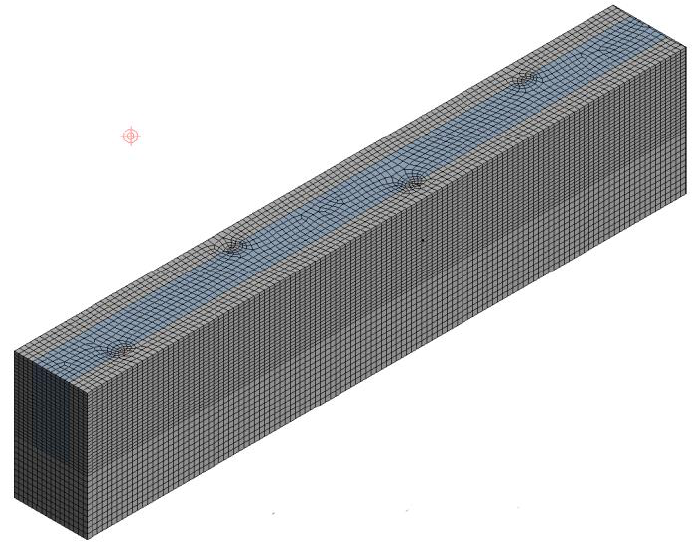
Figure 3. The mesh for the microchannel and fluid zone. Table 3. Mesh independence test.